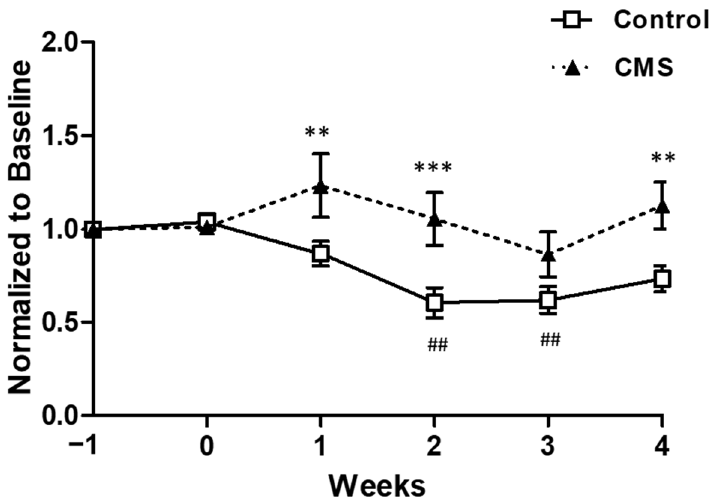
Figure 3. Sucrose intake of control and CMS. Data are presented as mean ± S.E.M. ** p < 0.01, *** p < 0.001 vs. control at the same time point, ## p < 0.01 vs. baseline (week − 1) within group, two-way repeated measures ANOVA followed by Dunnett’s, n = 7 for each group.